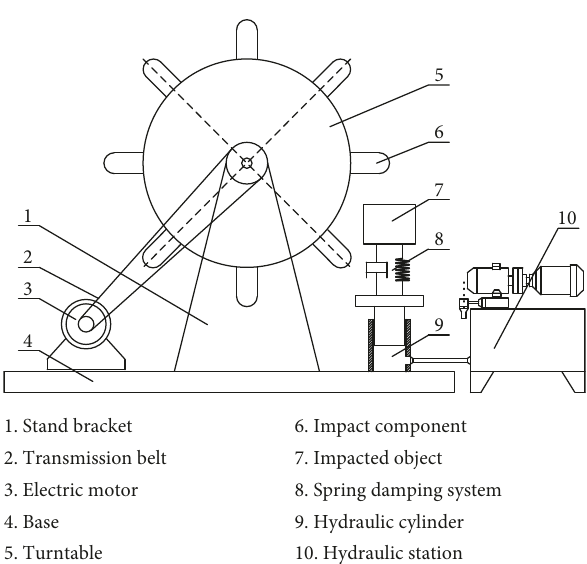
Figure 2: Principle of the multiple impact equipment